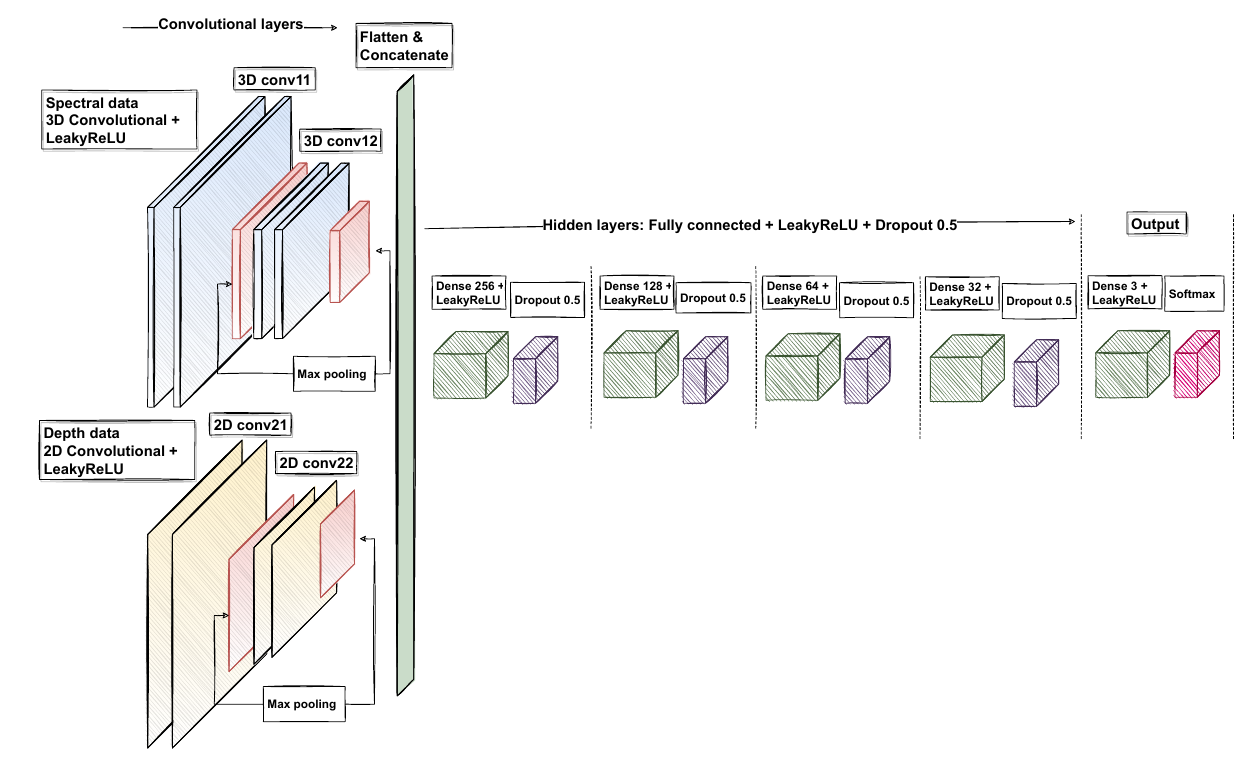
Figure 13. The visualisation of the used convolutional neural network. We used 3D layers with spectral data and 2D layers with depth data. The outputs were concatenated, flattened and used as an input for the hidden layers. The result was a three-class classifier for spectral data with depth